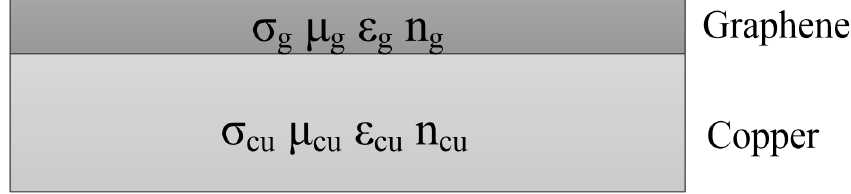
Figure 1. Electrode plate model.